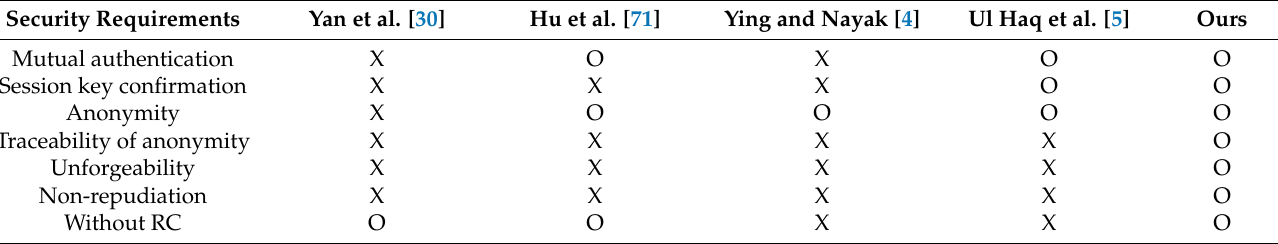
Table 4. Security requirements comparison.